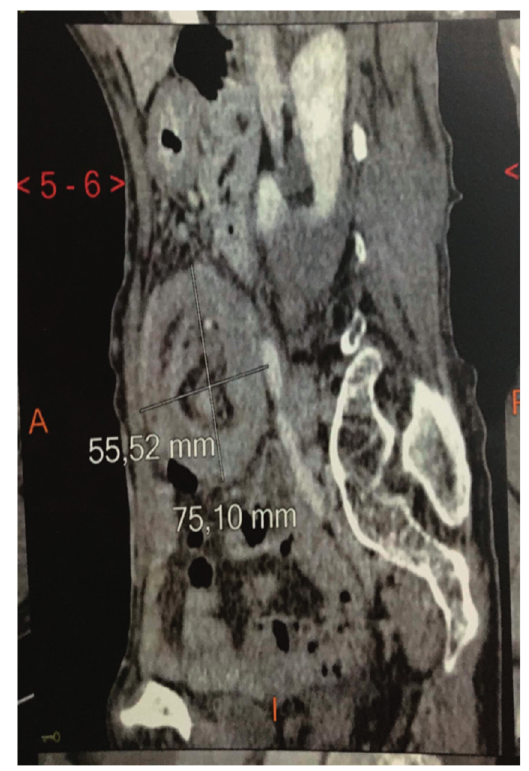
Figure 2: Abdominal CT scan showing large intestinal invagina- tion (heterogeneous digestive mass).